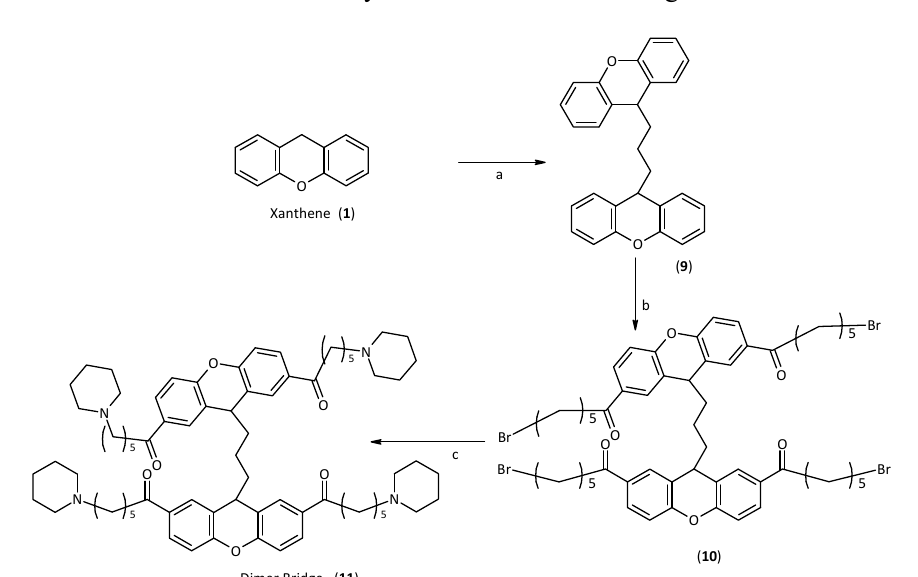
Scheme 3. Synthesis of the Dimer